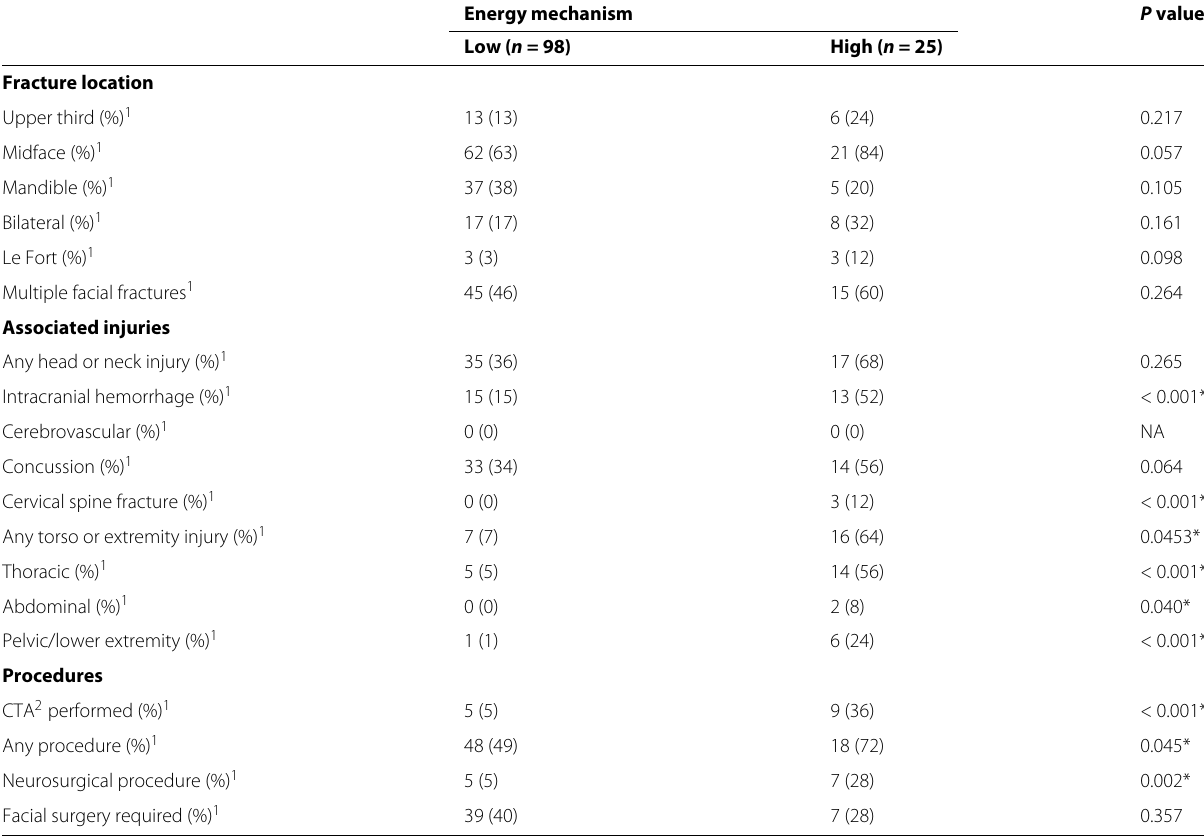
Table 3 Facial fracture location, associated injuries, and procedures